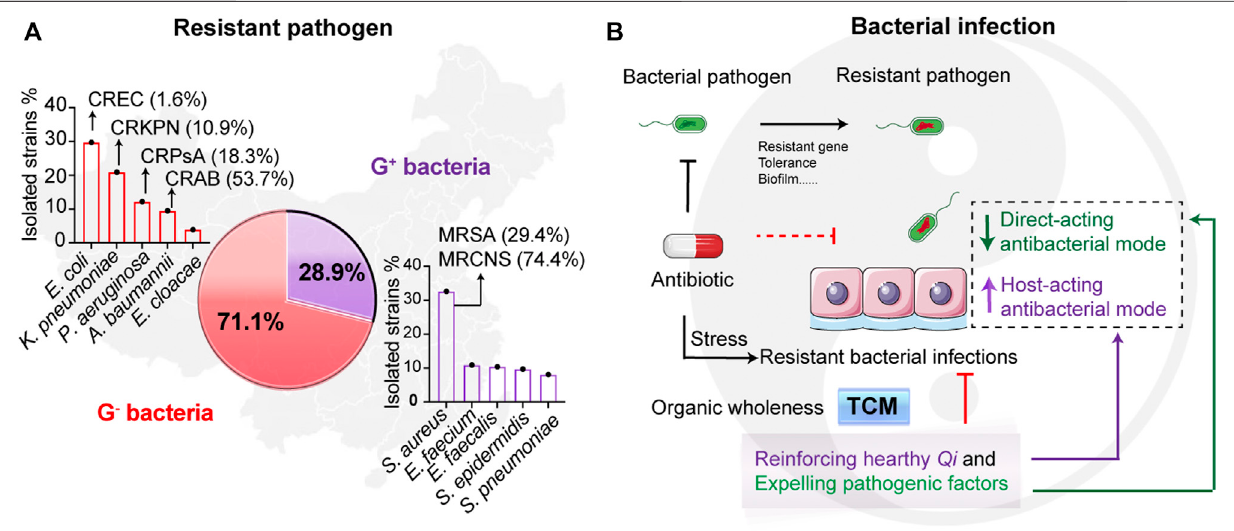
FIGURE1| ResistantpathogenicinfectionsandthetreatmentoftraditionalChinesemedicine. (A) TheoccurrenceofresistantpathogensinChinafrom10/2019to 12/2020. Reported dataarecollected fromChina Antimicrobial ResistanceSurveillanceSystem(CARSS) 1 . Theisolated resistant strains fromthereportthataccountfor Gram-negative (G − ) bacteria and Gram-positive (G + ) bacteria are 71.1% and 28.9%, respectively. (B) Scheme of the infectious therapy of traditional Chinese medicine (TCM). Resistant bacterial infections lead to the treatment failures of antibiotics. While therapeutic principles of TCM focus on the organic wholeness referring to “ reinforcing healthy Qi and expelling pathogenic factors, ” which displays that both suppressing bacteria and enhancing host defense. The TCM can divide to two types including direct-acting antibacterial mode and host-acting antibacterial mode. It is worth noting that “ Qi ” in TCM denoted the gas of host healthy, mostly meaning the forces of host